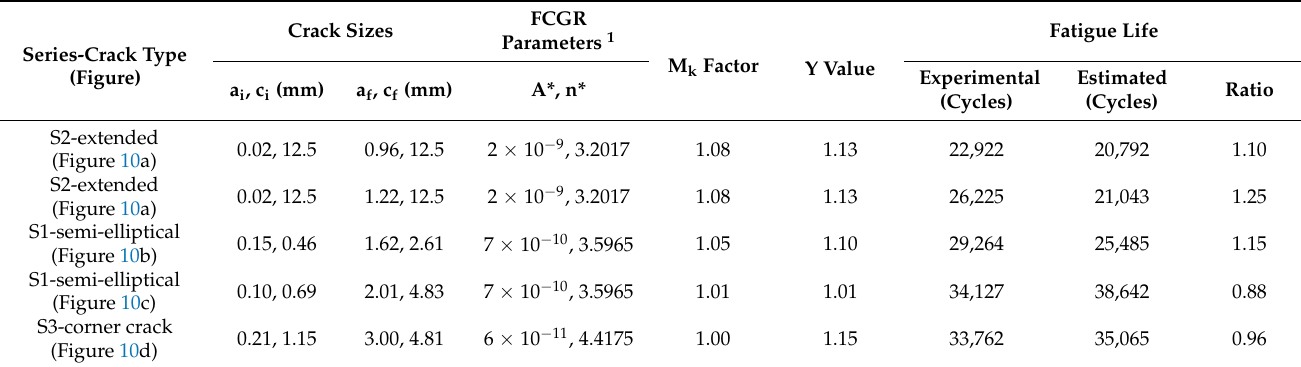
Table 5. Data and parameters for the estimation of the fatigue life.